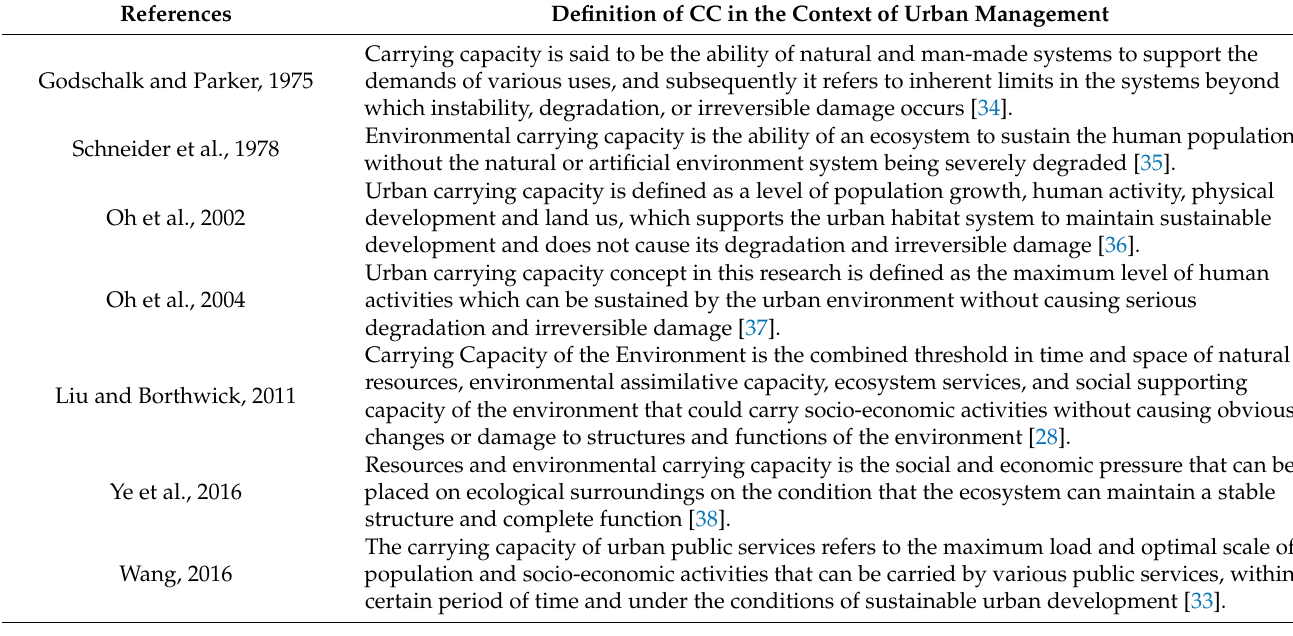
Table 1. Representative definitions of CC in the context of urban